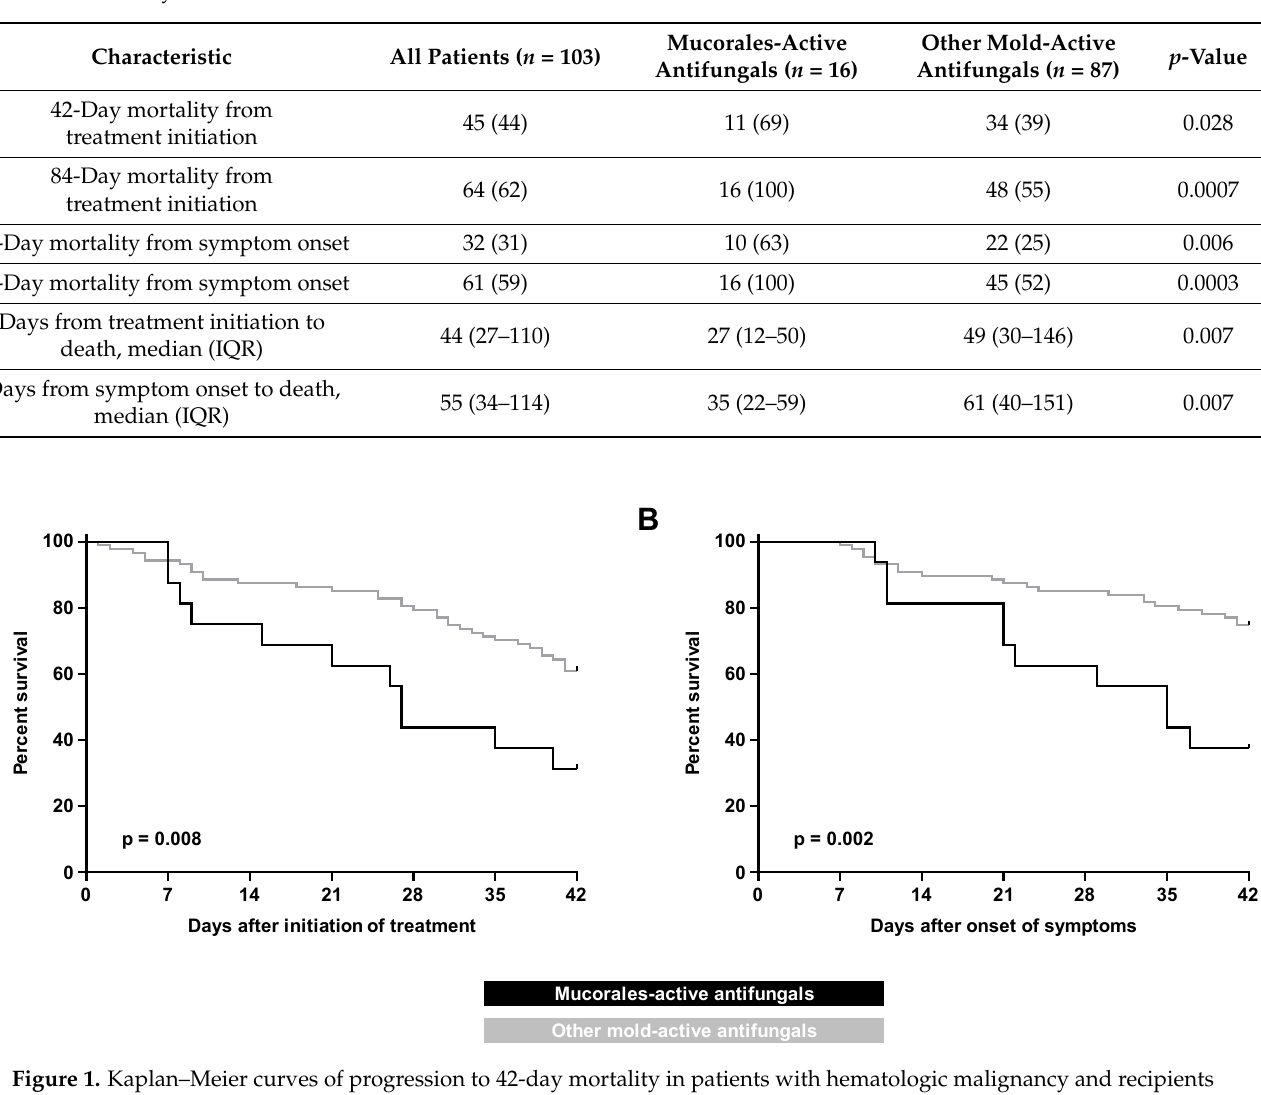
of hematopoietic stem cell transplants with breakthrough mucormycosis on Mucorales-active versus other mold-active